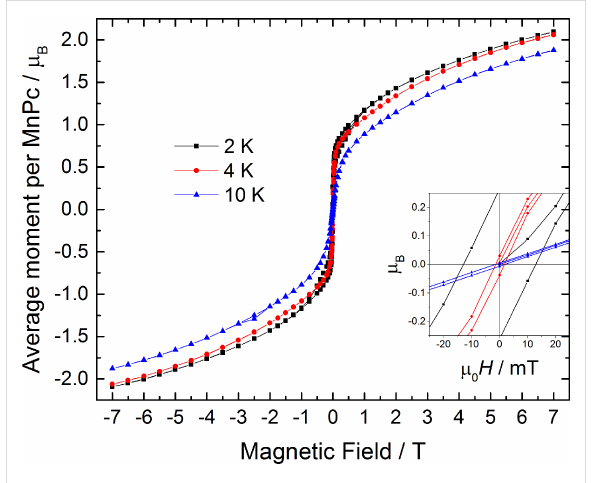
Figure 4: Magnetic hysteresis loops of a MnPc thin film on Kapton ob- tained from annealing of a MnPc:TCNQ blend. The inset shows that the film exhibits a coercivity of up to 13 mT at 2